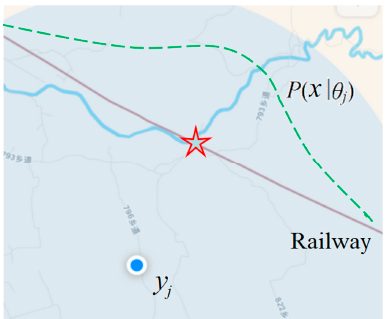
Figure 3. Illustrating the positioning of a GPS device with deviation. The round point is the pointed position with a deviation, and the position with the star is the most probable position.